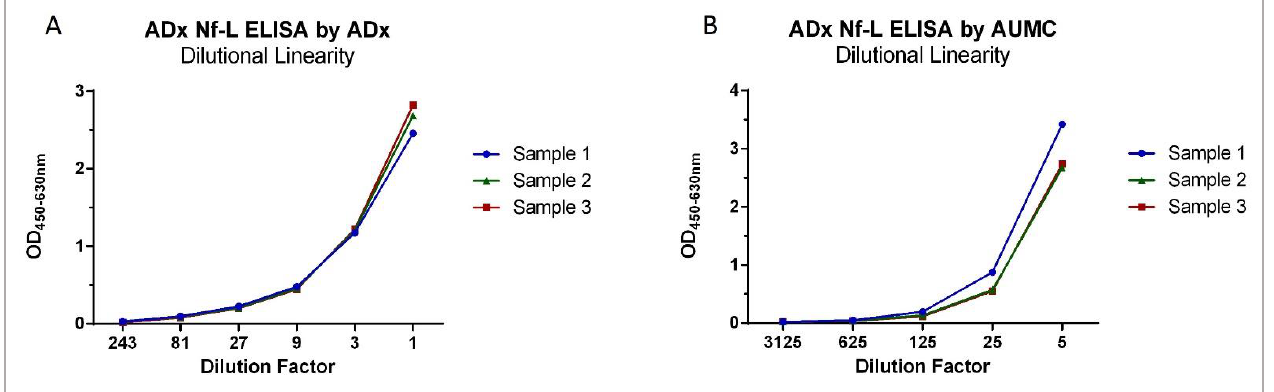
Figure 4. Dilutional Linearity. ( A ) Dilutional linearity of three CSF samples in the ADx Nf-L ELISA validated at ADx NeuroSciences. The three CSF samples were spiked with 30,000 pg/mL of bNf-L and maintained linearity within the acceptable range of 80 – 120% up to dilution factor 9, but at dilution factors of 21, 81, and 243, linearity deviated from the acceptable range (they were 137%, 127%, and 74% respectively). ( B ) Dilutional linearity of three CSF samples in the ADx Nf-L ELISA validated at AUMC. The samples were spiked with 100,000 pg/mL of bNf-L. All three samples maintained linearity within the acceptable range up to dilution factor 625, beyond which the signals dropped below their LLOQ.